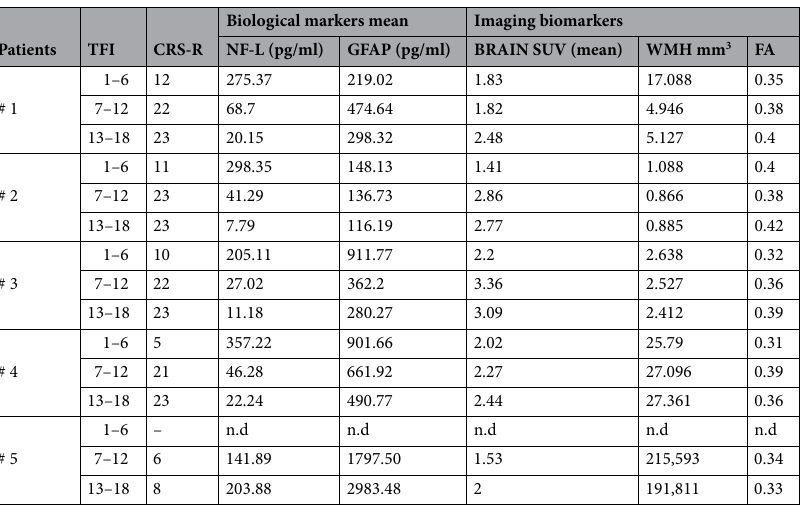
Table 2. Measurements of biological and imaging markers. Report of the biological and imaging markers mean values of the n = 5 follow up patients analyzed. TFI, Time from injury; CRS-R, Coma recovery Scale- revised; FA, Fractional anisotropy; n.d. = not